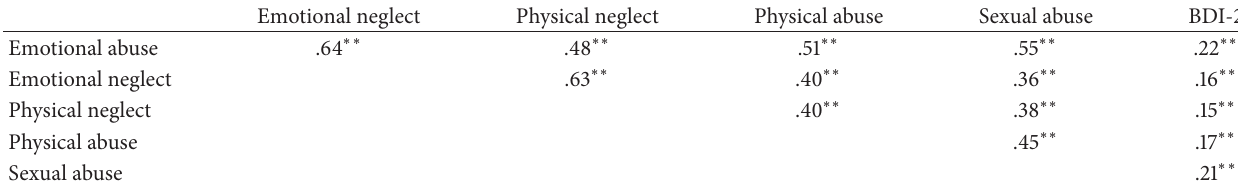
Table 3: Spearman correlations among the five CTQ subscales ( 𝑁 = 349 ).